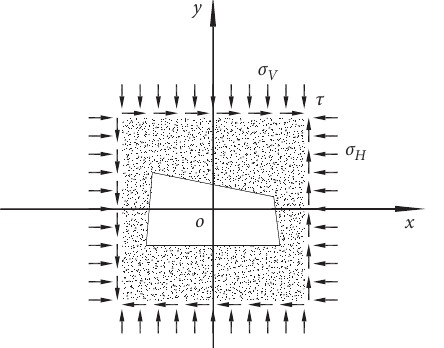
Figure 1: Stress diagram of